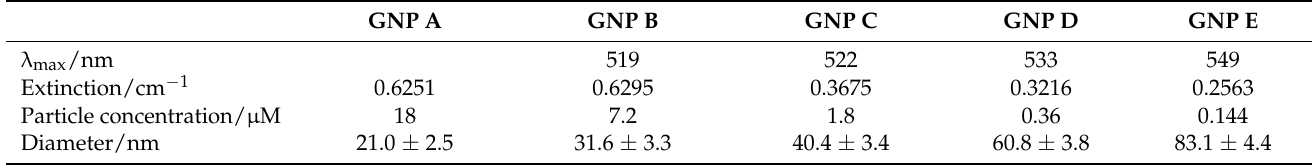
Table 1. Summary of GNPs. The number concentration of GNP seeds (2.5 × 10 − 8 M) was determined according to Beer’s law by using the extinction coefficient of 10 8 M − 1 · cm − 1 for 13 nm GNP in diameter at 520 nm. According to previous reports [33], duction of Au 3+ by NH 2 OH is dramatically accelerated by Au surfaces, as a result, no new particle nucleation occurs during the preparation of GNP A to GNP E. Therefore, their number concentration can be calculated based